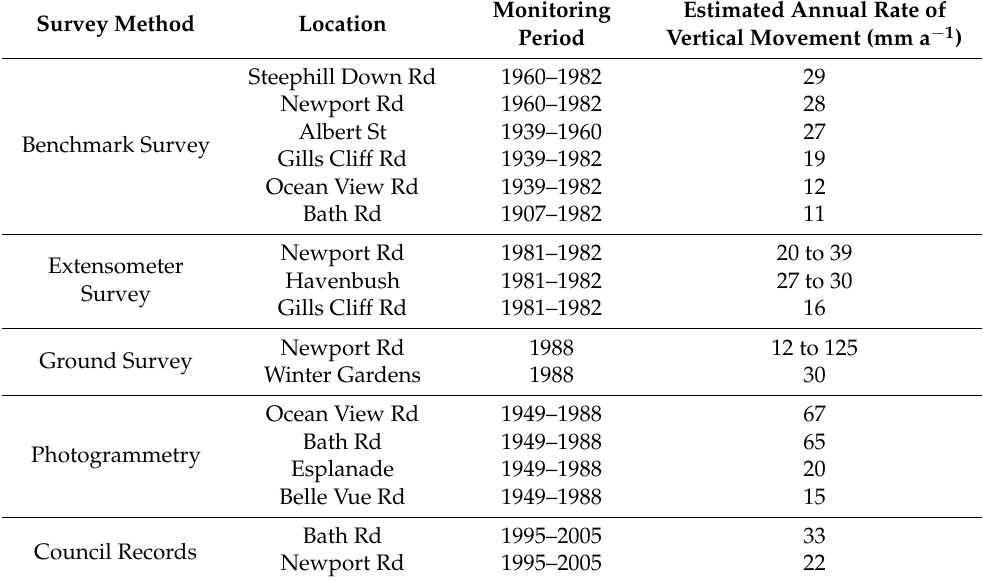
Table 1. Historical monitoring surveys at Ventnor, after Chandler [28], Geomorphological Services Limited [29], Moore et al.